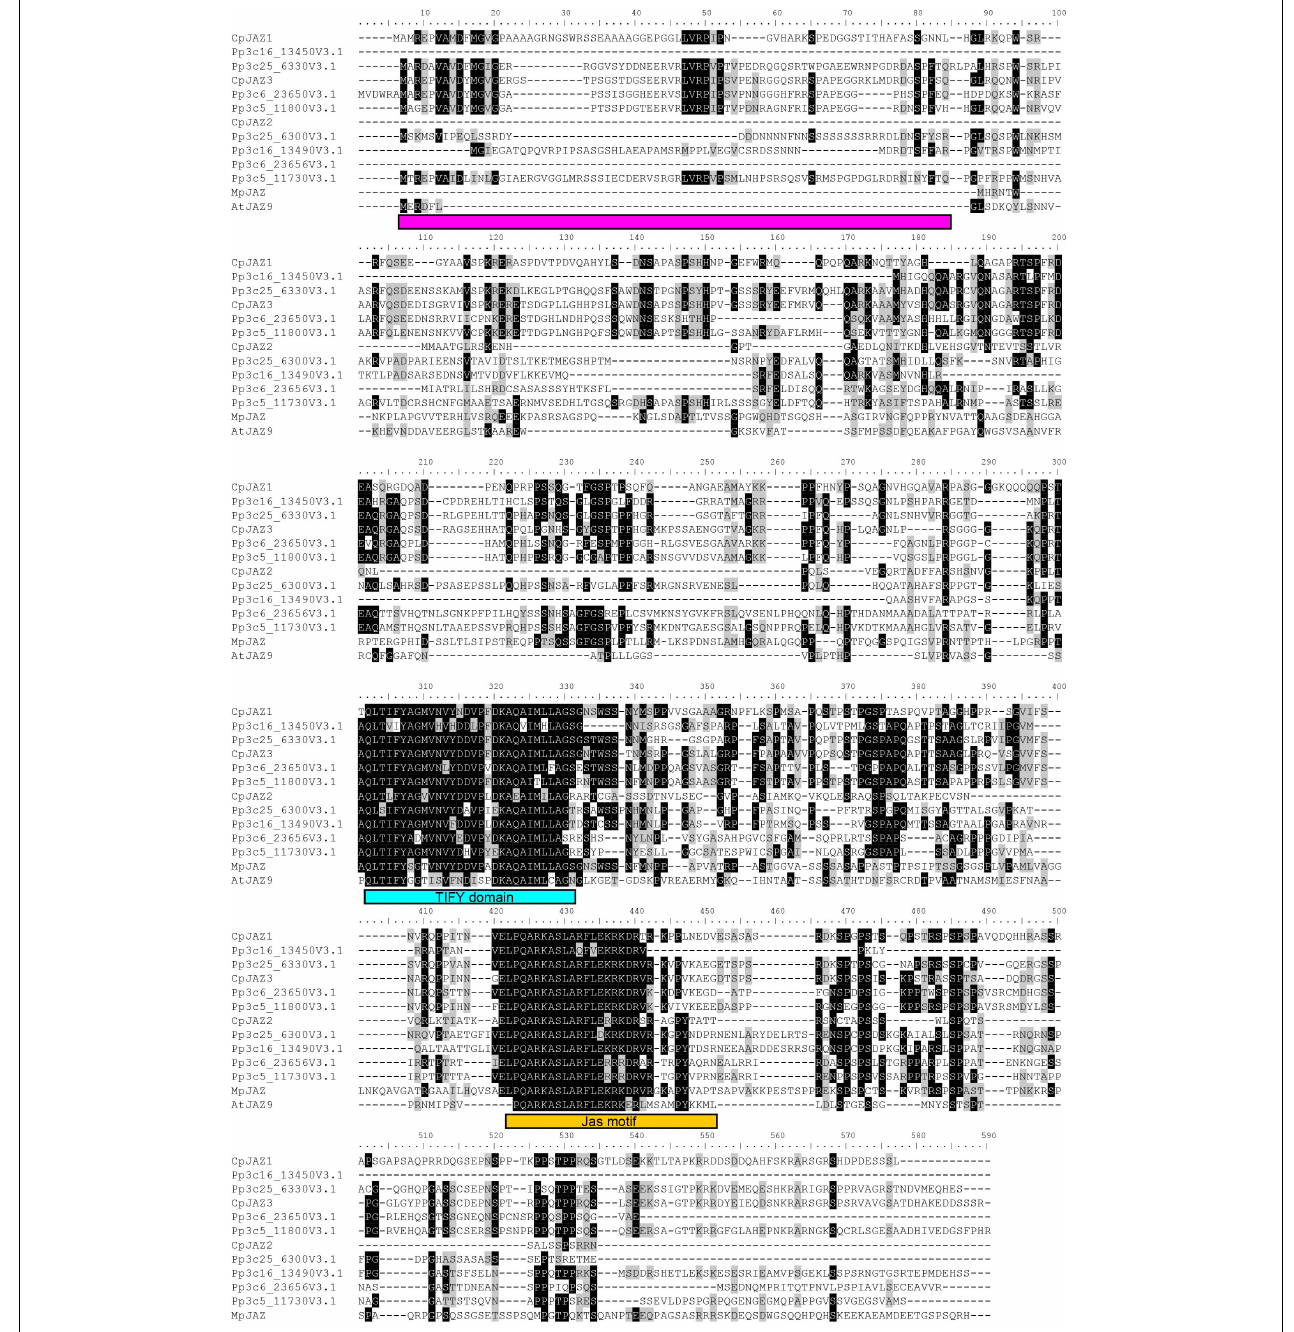
FIGURE 2 | Sequence alignment of JAZ proteins. Sequences of JAZ homologs were aligned using MEGA version X using Muscle. Sequence alignments were drawn using the BioEdit software version 7.2.5. The shading thresholds for identical or similar residues were 40%. Identical and similar residues are highlighted by black and gray, respectively. The TIFY domain and Jas motifs are indicated by blue and orange squares, respectively. The conserved sequence in the N-terminus of the moss JAZs is indicated by magenta